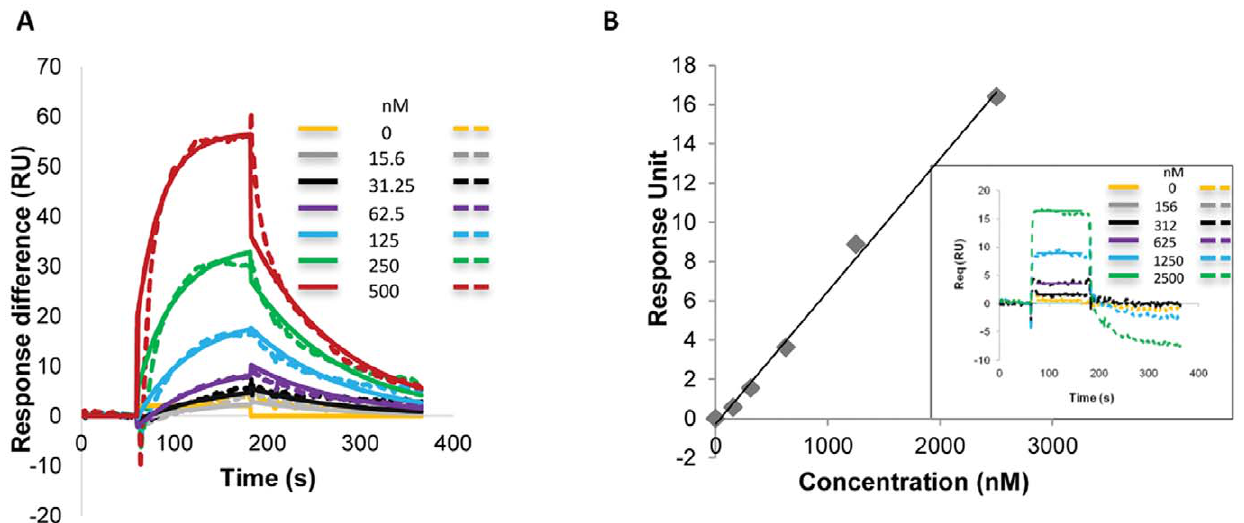
Figure 6. Binding measurements of LL-37 and of scrambled LL-37 to G-actin at high ionic strength. Biacore sensorgram [fit (solid) and experimental (dashed)] showing the interactions between LL-37 (A) or scrambled LL-37 (B) and actin, using series of concentrations of 0–500 nM (A), 0–2500 nM (B). Calculation for sLL-37 (B) were performed using a steady state affinity model based on the sensorgram shown as an insert in B. Presented data are representative of three independent experiments.